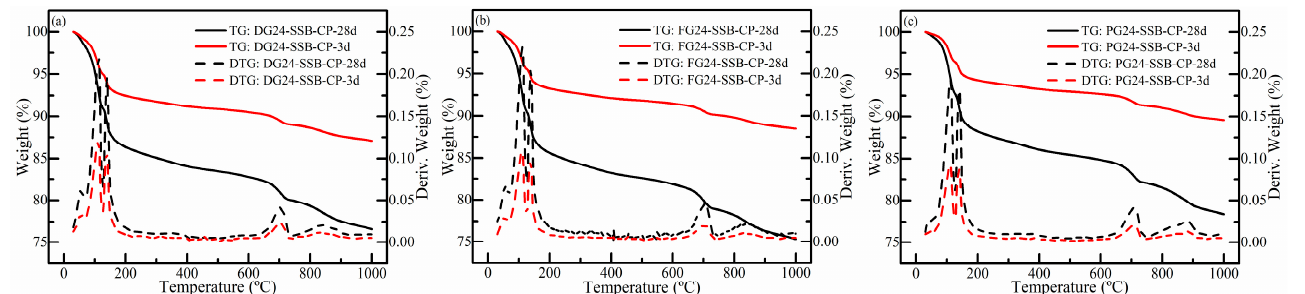
Figure 9. TG/DTG diagram for hardened SSB-CP with different gypsums: ( a ) DG24-SSB-CP, ( b ) FG24-SSB-CP, and ( c )PG24-SSB-CP.